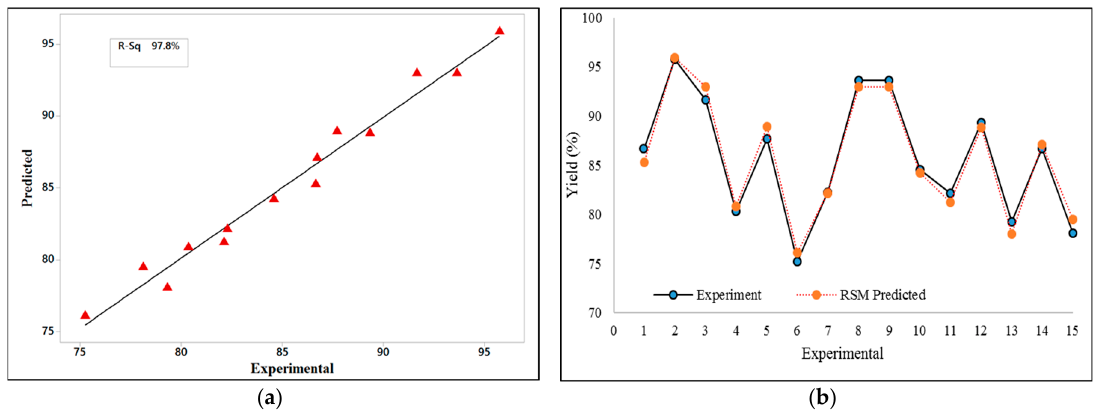
Figure 5. Biodiesel yield values (%): ( a ) Experimental versus ( b ) RSM predicted.